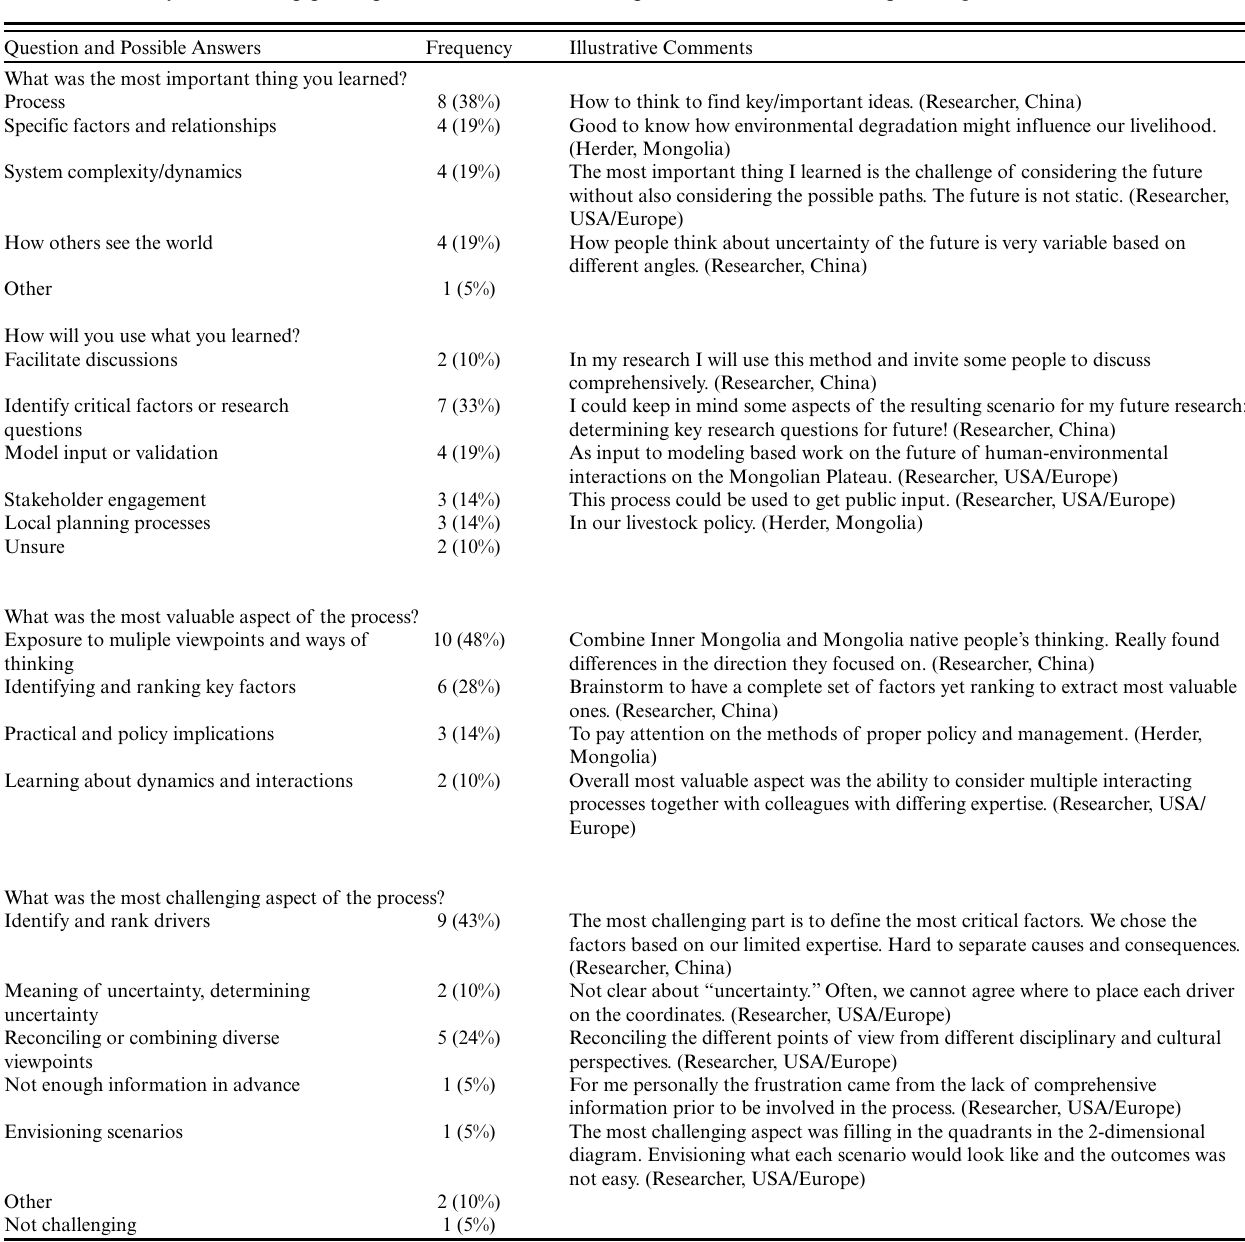
Table 2 . Summary of workshop participant evaluations of their experience with the scenario planning